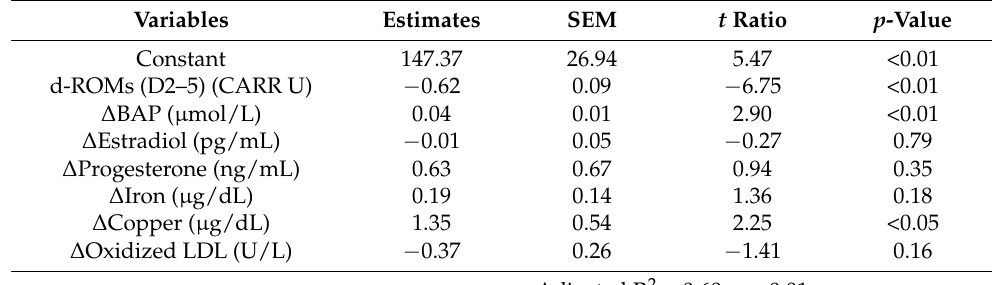
Table 3. Multiple regression models examining the influences of changes in various measures on shifts in d-ROMs in premenopausal